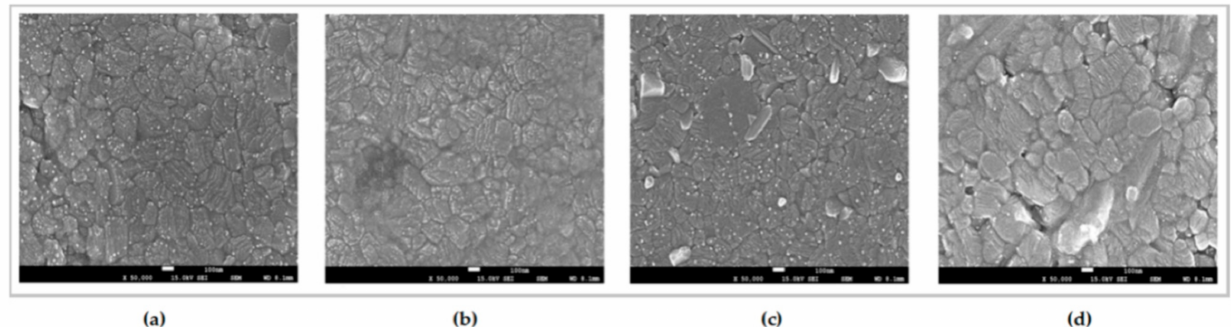
Figure 3. Scanning electron microscopy (SEM) images of the Dy 2 O 3 –doped 0.98BaTiO 3 -0.02(Ba 0.5 Ca 0.5 )SiO 3 ceramics sintered at 1320 ◦ C for 1 h. (bar: 100 nm): ( a ) 0.0, ( b ) 0.1, ( c ) 0.2, ( d ) 0.3 wt.% Dy 2 O 3